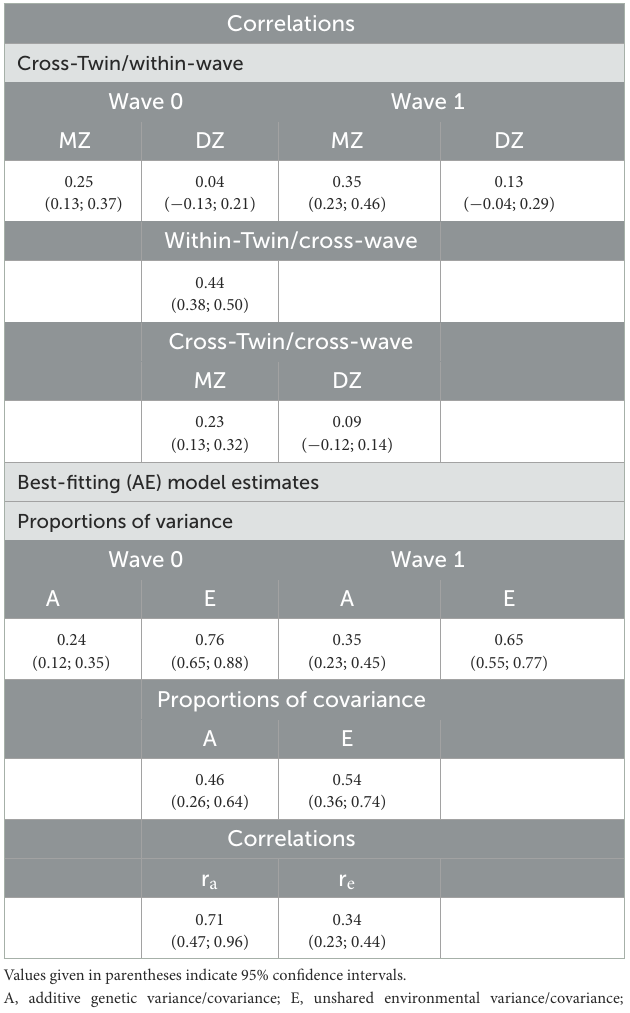
TABLE 1 Correlation patterns and best-fitting model’s estimates for depression